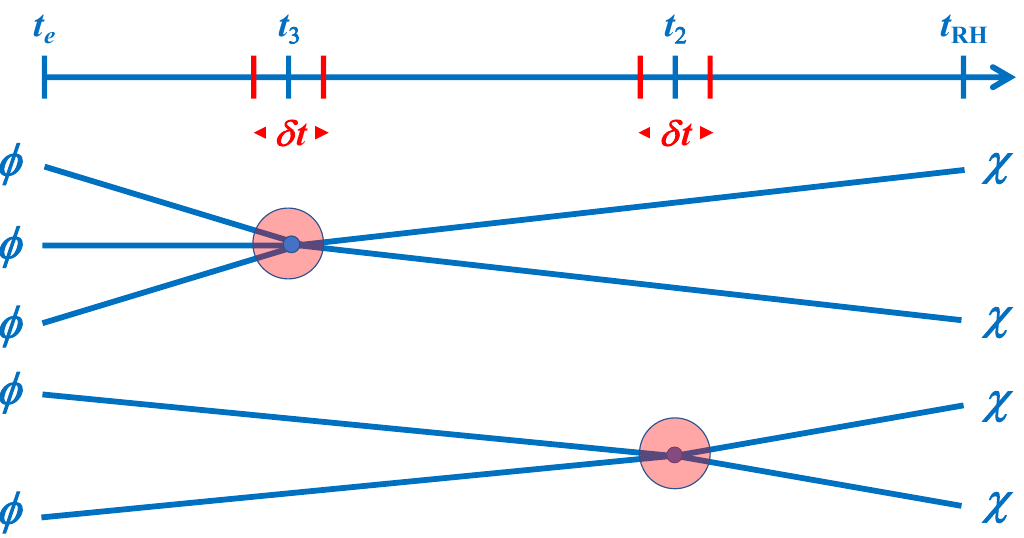
Figure 3 . The Schrödinger propagator phase difference between 3 φ → 2 χ and 2 φ → 2 χ scatter- ings leads to interference. The disk region of diameter δt represents the usual collision region of Boltzmann equation, which is typically treated with an S-matrix taking the formal limit δt → ∞ . The observable interference phase of χ is the Schrödinger-picture free-particle propagator between t 3 and t 2 . The φ -interference phase can contain t e information as 3 φ propagation phase from t e to t 3 does not cancel the 2 φ propagation conjugate phase from t e to t 3